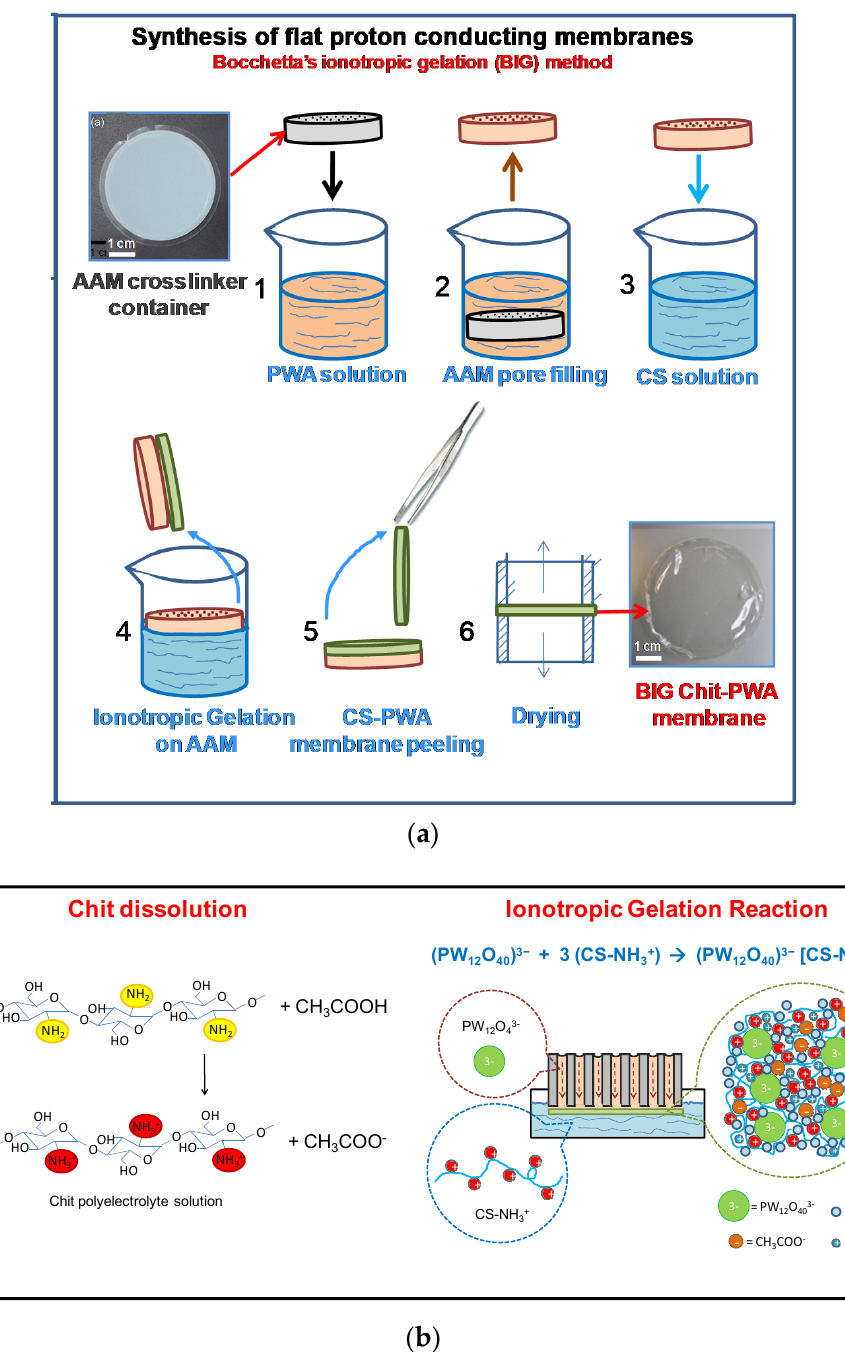
Figure 9. ( a ) The BIG method: steps of the procedure of proton conducting Chit-PWA flat membranes formation. ( b ) Scheme of Chit polyelectrolyte dissolution in acid acetic solution (left) and ionotropic gelation of chitosan through cross-linking with PWA 3 − anions (right). Reproduced from Ref. [9] under open access CC-BY license.